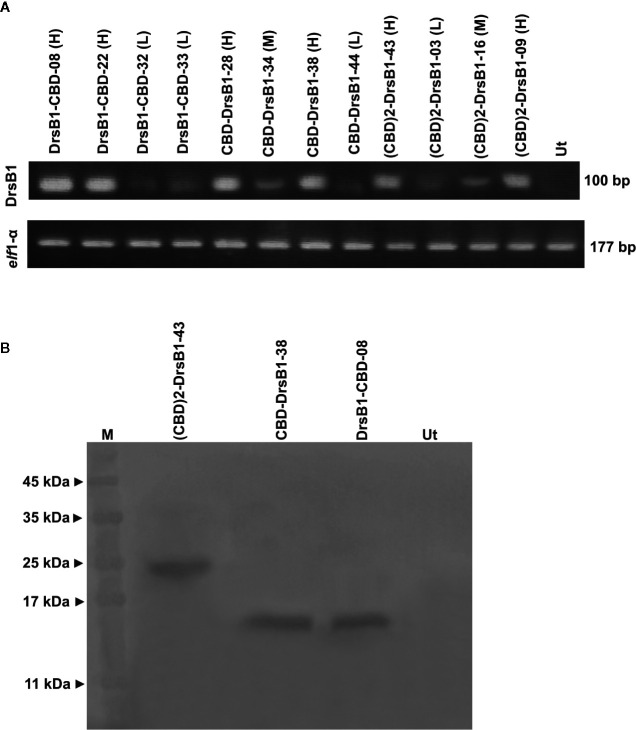
Semi-quantitative RT-PCR (A) and western blotting (B) analysis of transgenic and control plants. The upper panel shows the PCR products of the CBD-DrsB1, (CBD)2-DrsB1, and DrsB1-CBD recombinant genes in the selected transgenic line and the lower panel shows the PCR products elf housekeeping gene. Mouse monoclonal anti-His antibody (Sigma-Aldrich, product No. A7058) was used for recombinant peptides detection.